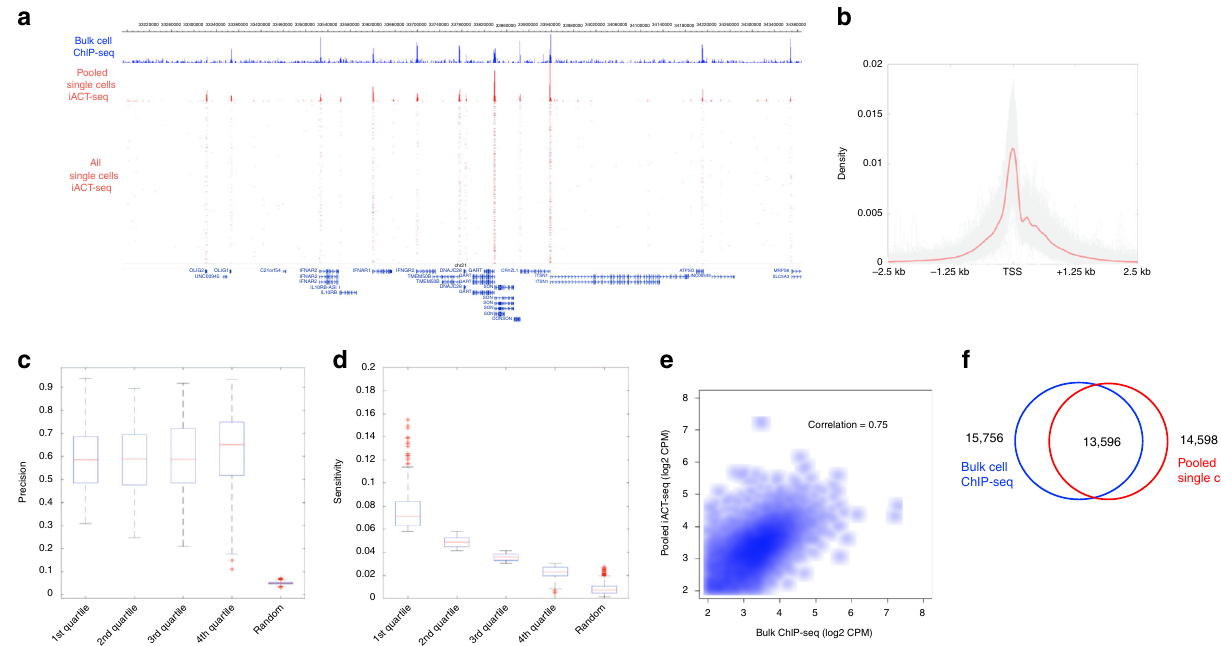
Fig. 2 ACT-seq reproducibly maps epigenetic marks in single cells. a Genome browser image of H3K4me3 peaks from bulk-cell ChIP-seq (blue) and pooled iACT-seq (red). The mapped reads from all 1246 individual cells are plotted below the aggregate peaks. Each row represents a single cell. b Metagene pro fi le of H3K4me3 enrichment at the TSS region of genes from the hg18 genome for all single cells. The red line indicates average enrichment for all single cells from the iACT-seq data set. c , d Precision and sensitivity plots for the H3K4me3 scACT-seq data set. These values were calculated in the same manner as was done previously 16 . Data are divided into quartiles with the central marks indicating the median values. The bottom and top edges of the boxes indicate the 25th and 75th percentiles, respectively. The whiskers indicate the boundaries of the data. e Scatter plots depicting the correlation in H3K4me3 peak enrichment in counts per million (CPM) between ENCODE bulk-cell ChIP-seq data ( x -axis) and pooled scACT-seq data ( y -axes). Peaks identi fi ed as enriched using both the ChIP-seq and scACT-seq methods were included. f Venn diagram indicating the numbers of signi fi cantly enriched H3K4me3 peaks with at least 1 bp overlap between a bulk-cell ENCODE ChIP-seq data set (blue) and pooled scACT-seq data